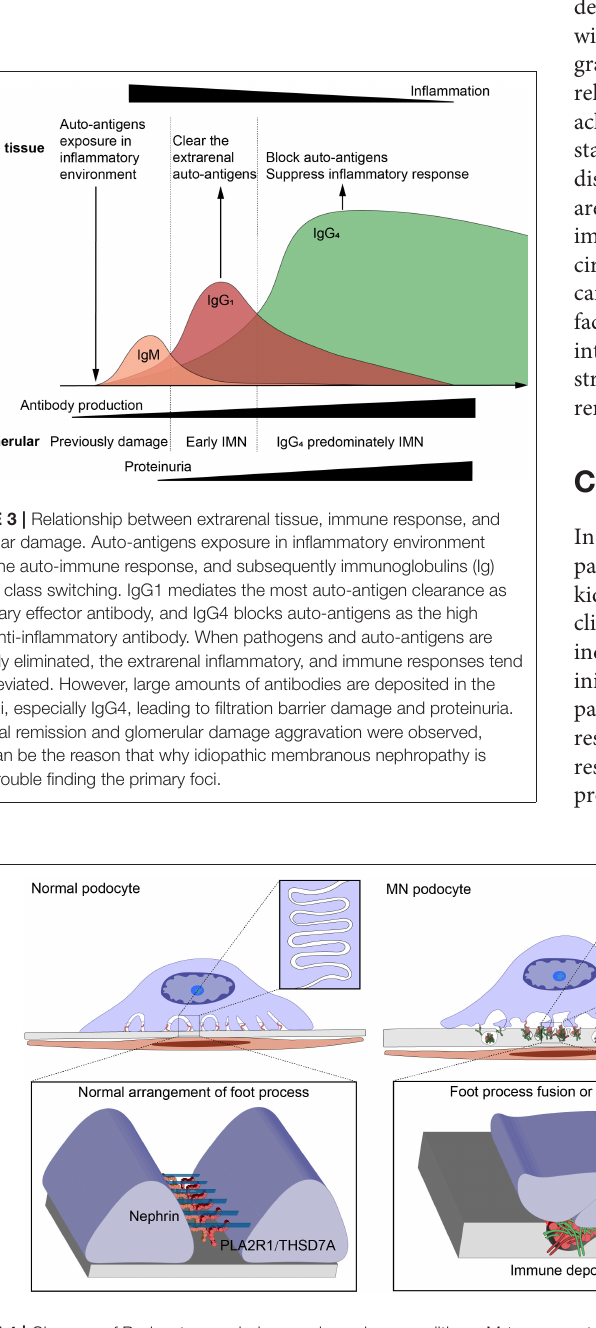
Frontiers in Immunology |